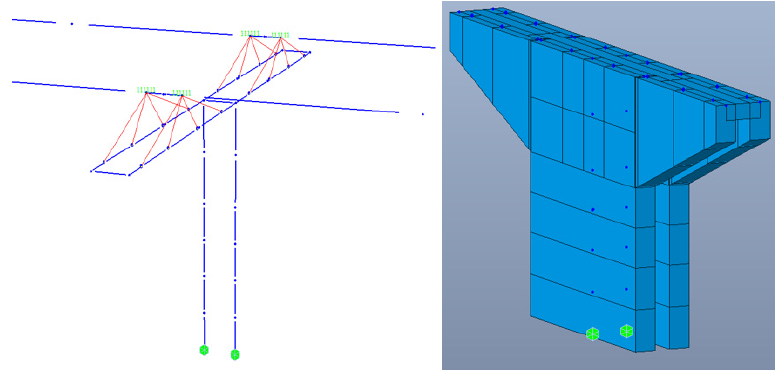
Figure 9. Finite element model of the pile ‐ type using tapered beams where “rigid ‐ links” are illus ‐ trated and modelled to simulate the real distance between the barycentric longitudinal axis of the deck and the neoprene support on the pulvinus.